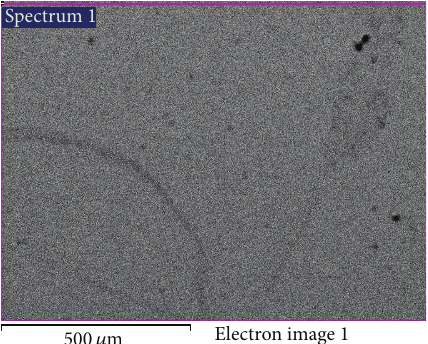
Figure 1: Scanning electron micrograph (SEM) of PbTe doped with 1.4 at% Cu showing EDS sampling surface.